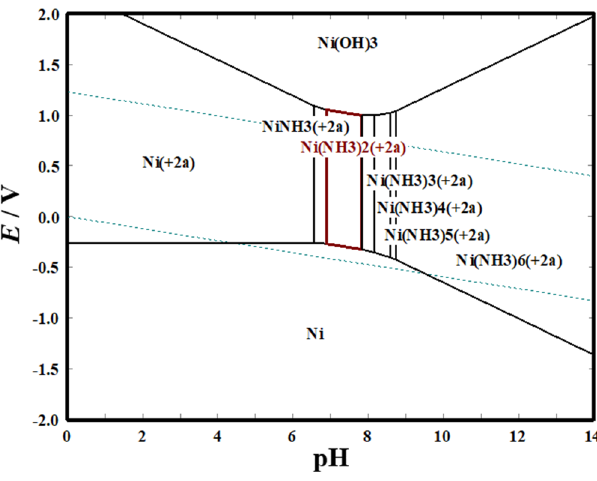
Figure 2. E -pH diagram of solution with 0.2 M NiCl 2 , 2 M NH 4 Cl, and 1 M NaCl at 25 °C.